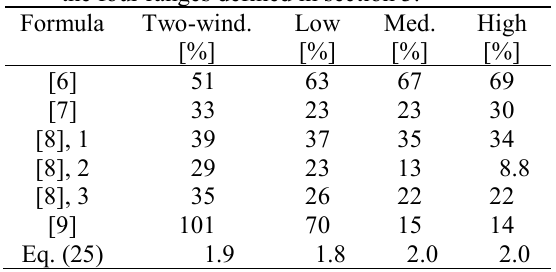
Table 2: The maximum relative errors of the formulae from the literature together with those of equation (25) for the four ranges defined in section 3.